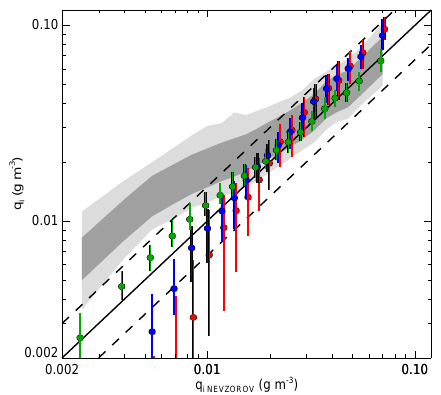
Figure 5. A comparison of Nevzorov data against the other q i mea- surement techniques. The TWP-minus-WVSS-II method is shown in red, the CVI in blue and the integration of the PSD using the temperature-dependent relation M = 0 . 05 D b(T) from this study in green (see Table 1). The data are from flight B762 in cirrus cloud be- tween temperatures of − 48 and − 9 ◦ C. Each filled circle represents the median value and the vertical bars the 25th to 75th percentile range from 10min of flight data. The dark/light grey shading spans the extremities of the median/interquartile range when integrating the PSD using a selection of other temperature-invariant M – D rela- tions for ice (see Table 1). The solid line is the 1 : 1 line. The dashed lines represent agreement to within a factor of